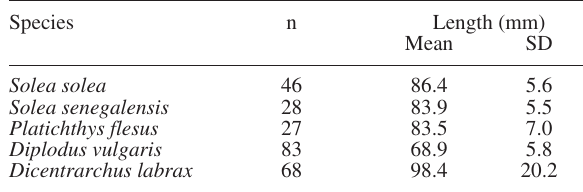
Table 2. – Number (n) and mean total length (mm) (and standard deviation, SD) of juvenile Solea solea , Solea senegalensis ,